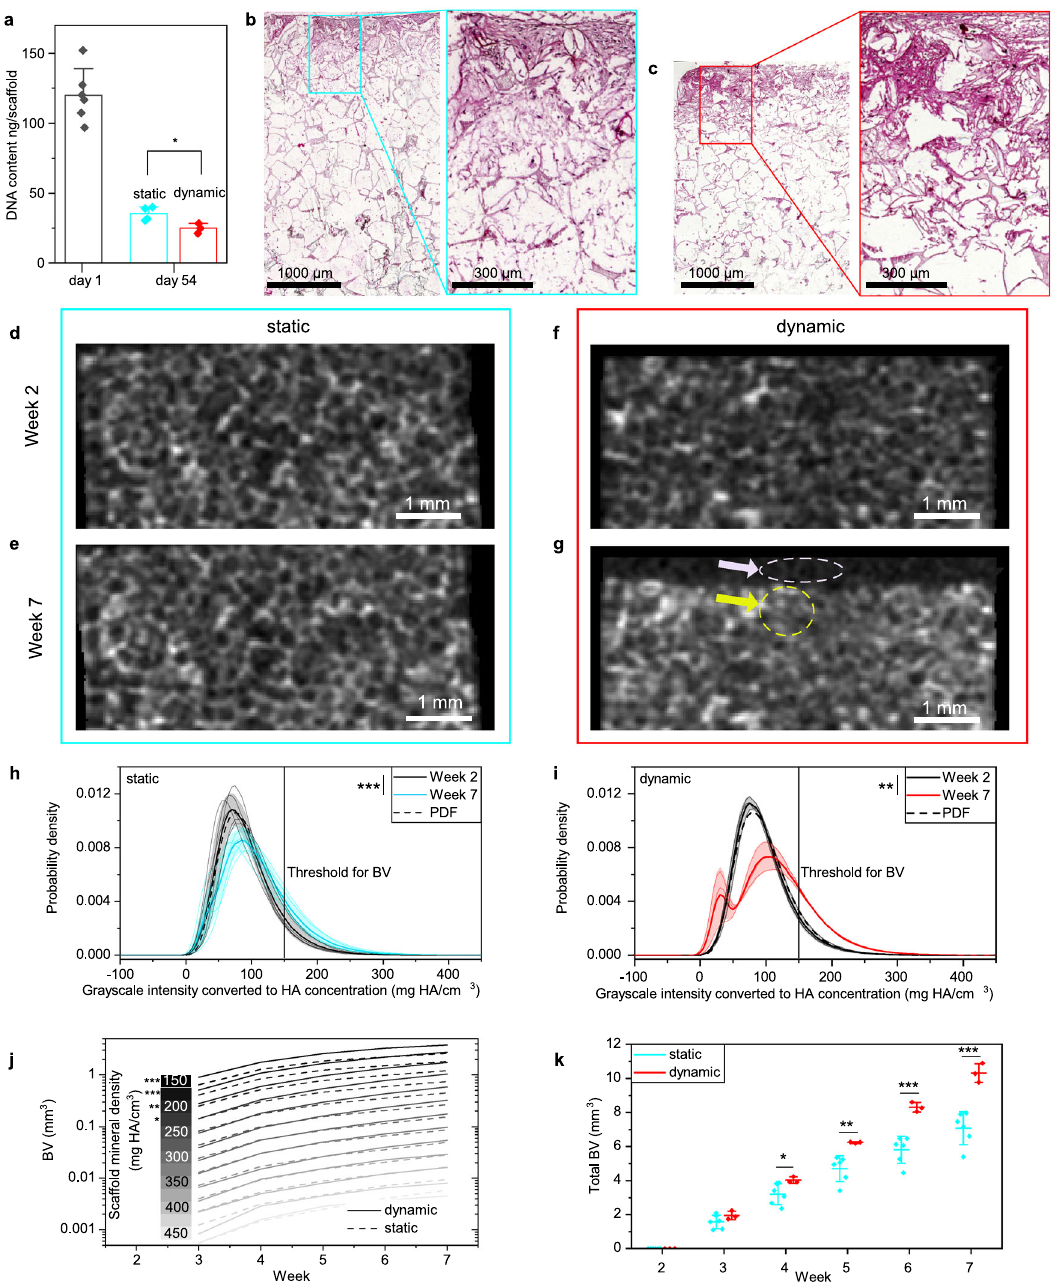
Fig. 3 Cell distribution, time-lapsed micro-CT monitoring of HA55-PLGA (u) scaffolds, 1Hz and 5% strain. a DNA content per scaffold at day 1 ( n = 6) and 54 (static n = 4, dynamic n = 3). Columns represent mean and error bars the s.d.; * p < 0.05; t -test. b Microscopy image of a hematoxylin and eosin stained vertical cross-section in a scaffold cultured under static condition and c under dynamic condition. d Representative micro-CT cross-sectional slice of a scaffold cultured under static condition from week 2 and e week 7, respectively, of a scaffold cultured under dynamic condition ( f , g ). h Histogram of 3D grayscale images of static ( n = 6) and dynamic ( i , n = 3) cultured scaffolds. Lines represent the mean and the shaded area the s.d. Dashed line represents the probability density function (PDF) for week 2; ** p < 0.01, *** p < 0.001; paired t -test. j Average bone volume (BV) as function of culture time for mineral densities above the threshold shown in h ; * p < 0.05 t -test for week 7, dynamic vs. static. k Total BV as function of time for static ( n = 6) and dynamic ( n = 3) culture conditions. Symbols represent the mean and error bars the s.d. * p < 0.05, ** p < 0.01, *** p < 0.001; t -tests were used to highlight differences between both conditions for each time-point. Shapiro – Wilk normality and Levene ’ s test for equality of variances were not signi fi here is visible under micro-CT (Fig. 3d, f) due to the representative noise fi ltered cross-sectional images from such hydroxyapatite nano fi ller, interfering with established scaffold scans of HA55-PLGA (u) scaffolds after 2 weeks (Fig. 3d, f) and image processing methods 46 . Thus, a re fi ned procedure based on 7 weeks (Fig. 3e, g) of static (Fig. 3d, e) and dynamic (Fig. 3f, g) the histogram of time-lapsed micro-CT images is required to cell culture. The intensities of the voxels in the grayscale images distinguish bone nanocomposite material from newly formed correspond to the material density in mg HA/cm 3 . In contrast to previous studies on silk scaffolds 45 , the bone nanocomposite used mineral. Figure 3h, i shows histograms as normalized density